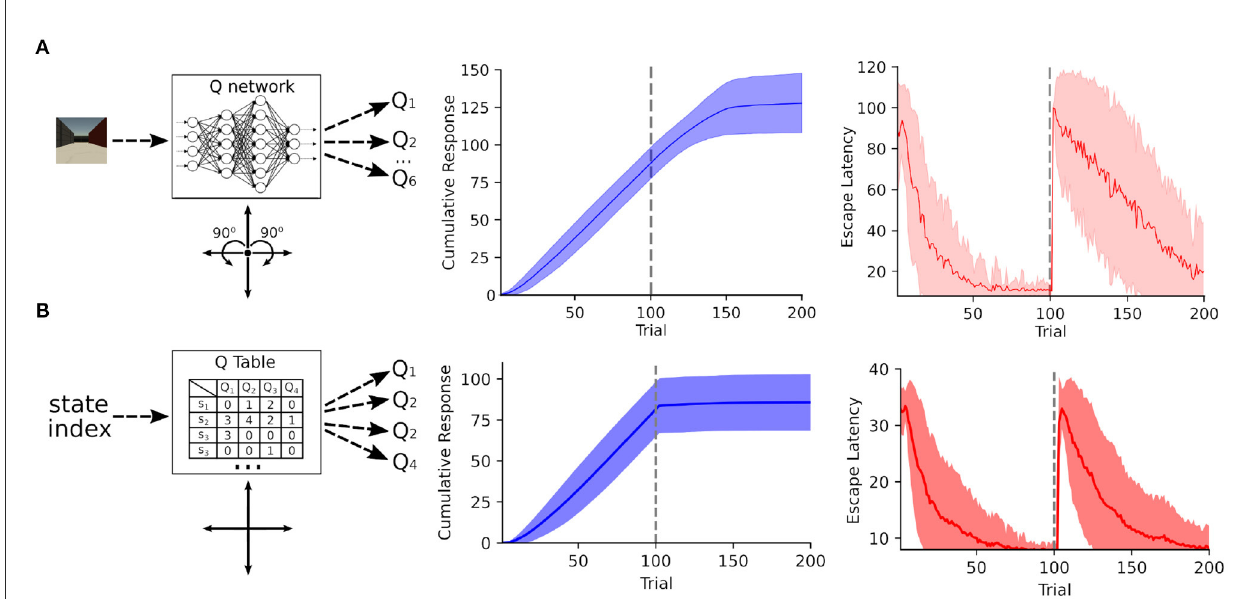
FIGURE6 Analysis of behavior in an extinction learning paradigm. (A) A DQN agent was trained on a simple extinction paradigm within a complex 3D Unity environment (left). The agent has six actions at its disposal: movement in either of the four cardinal directions and rotating either left or right by 90 ◦ . The cumulative response (center) reveals that the agent reliable picks the rewarded right arm for the first 100 trials. After the right arm was no longer rewarded (trials 101–200), the previously learned behavior initially persists and then gradually extinguishes. The escape latency curves (right) show that agent quickly learned to reach the right arm. After the reward switched the agent slowly adapted to the new reward location. (B) Same as (A) but recorded from a Dyna-Q agent (left) in a gridworld environment. Unlike the DQN agent the Dyna-Q agent can only move in the four cardinal directions. Similar to the DQN agent the Dyna-Q agent reliably picks the rewarded right arm for the first 100 trials. However, due to the Q-function’s tabular representation the previously learned behavior extinguishes